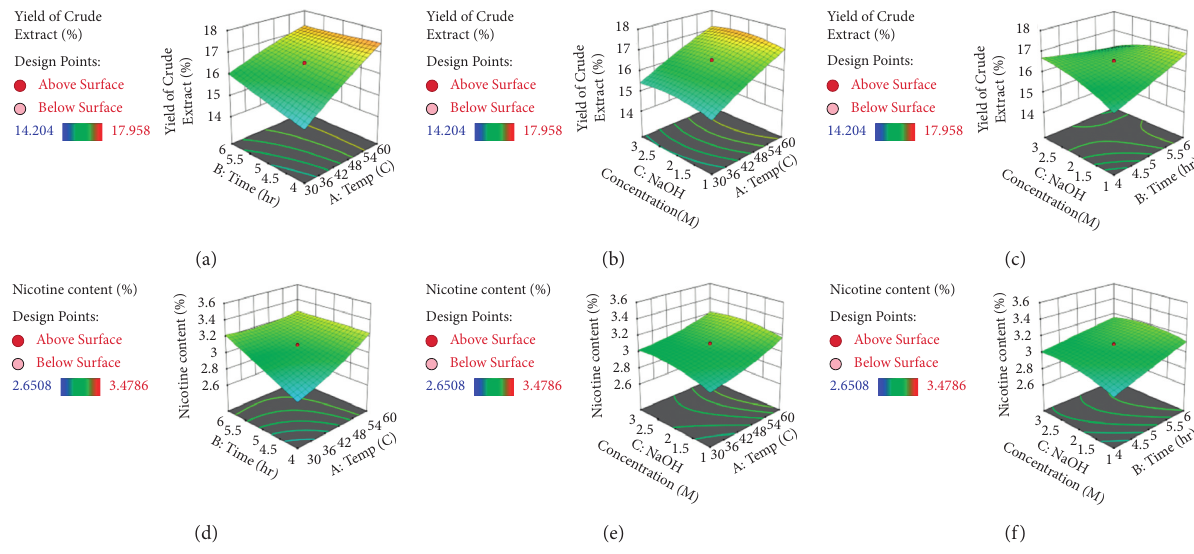
Figure 6: Interactive effects: 3D response surface plots of (a) time, temperature; (b) temperature, NaOH concentration; (c) time, NaOH concentration on yield of extract; (d) time, temperature; (e) temperature, NaOH concentration; (f) time, NaOH Concentration on nicotine content.